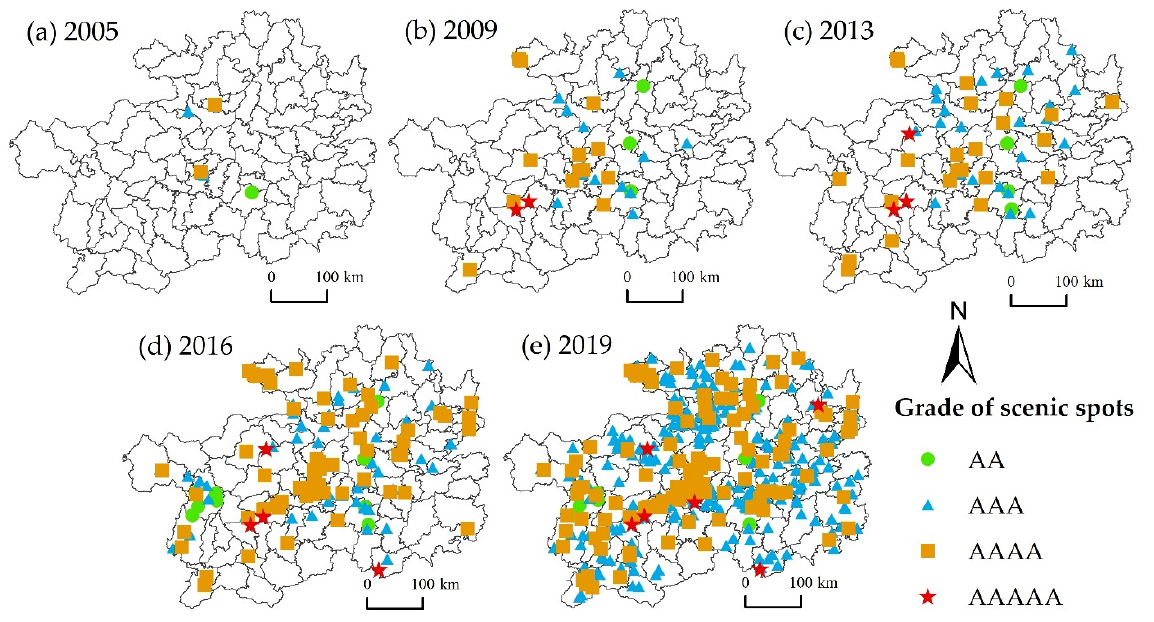
Figure 3. Spatial distribution of A-level scenic spots in Guizhou Province, ( a ) Spatial distribution of A-level scenic spots in 2005, ( b ) Spatial distribution of A-level scenic spots in 2009, ( c ) Spatial distribution of A-level scenic spots in 2013, ( d ) Spatial distribution of A-level scenic spots in 2016, ( e ) Spatial distribution of A-level scenic spots in 2019.